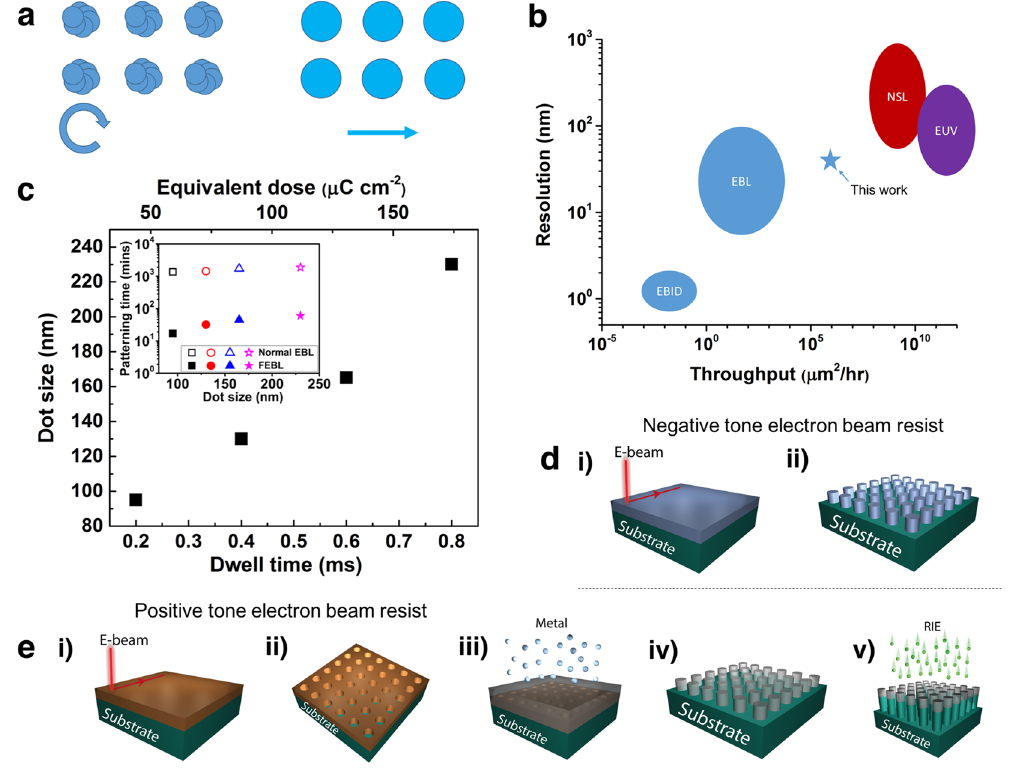
Figure 1. Fast Electron Beam Lithography (FEBL) patterning technique. ( a ) Patterning method for conventional e-beam lithography (left) vs. fast electron beam patterning technique (right). The former breaks down circular elements into multiple polygons; this pattern fracturing time contributes significantly to the total patterning time. In the FEBL patterning technique, the beam rasters continuously across the sample and dwells at specified points to define the spacing between adjacent elements. The diameter of the individual circular element is defined by the dwell time. ( b ) Resolution vs. throughput for selected nanolithography techniques. High throughput techniques such as nanosphere lithography (NSL) and current state-of-the-art photolithography (extreme ultraviolet EUV lithography) are wafer level techniques with very high throughput (over 10 9 µ m 2 /hr) with resolutions down to tens of nm. However, the pattern is pre-determined by the size of the nanosphere used in NSL and the optical mask for optical lithography. In contrast, direct write techniques such as EBL and electron beam induced deposition (EBID) offer much more flexible nano-patterning solution with sub-nm resolution. However, their throughput is limited to typically below 10 4 µ m 2 /hr (single beam system). The blue star indicates the throughput achieved by the FEBL technique for patterning nanodot arrays over millimetre-sized areas. ( c ) Dot (hole) size vs dwell time for the FEBL patterning technique applied to create PMMA holes on an InGaAs substrate. The array period was set to 500 nm. Over this interval the dot size increases roughly linearly with the electron beam spot dwell time. The equivalent beam dose scale is also provided. Inset, comparison of the patterning time for 1 mm × 1 mm array of nanoholes on PMMA with various hole diameters. The array period was 500 nm. The FEBL patterning technique is fully compatible with typical process flows for fabrication of nanodots and nanopillar arrays. ( d ) (i) Beam exposure on negative tone resist and (ii) Nanodot arrays formed after resist development. ( e ) (i) Beam exposure on positive tone resist. (ii) Nanoholes are left behind after resist development. (iii) and (iv) Metallic nanodots are fabricated after metal evaporation or sputtering followed by lift off. (v) We can also use the metal as etch mask for reactive ion etching (RIE) to fabricate high aspect ratio nanopillar